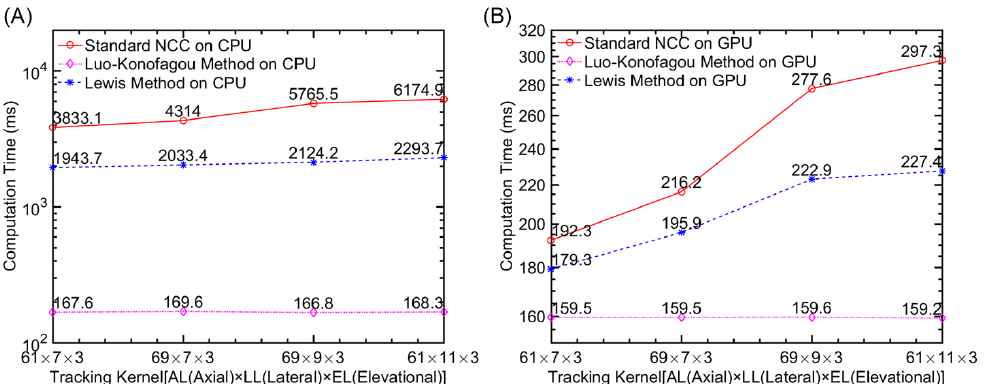
Figure 6. Plots comparing computational efficiency under two different environments: ( A ) CPU and ( B ) GPU. In ( A ), the computing time is displayed in log 10 scale. Computing time was estimated based on the completion of 3-D motion tracking for a single slice of ultrasound data.